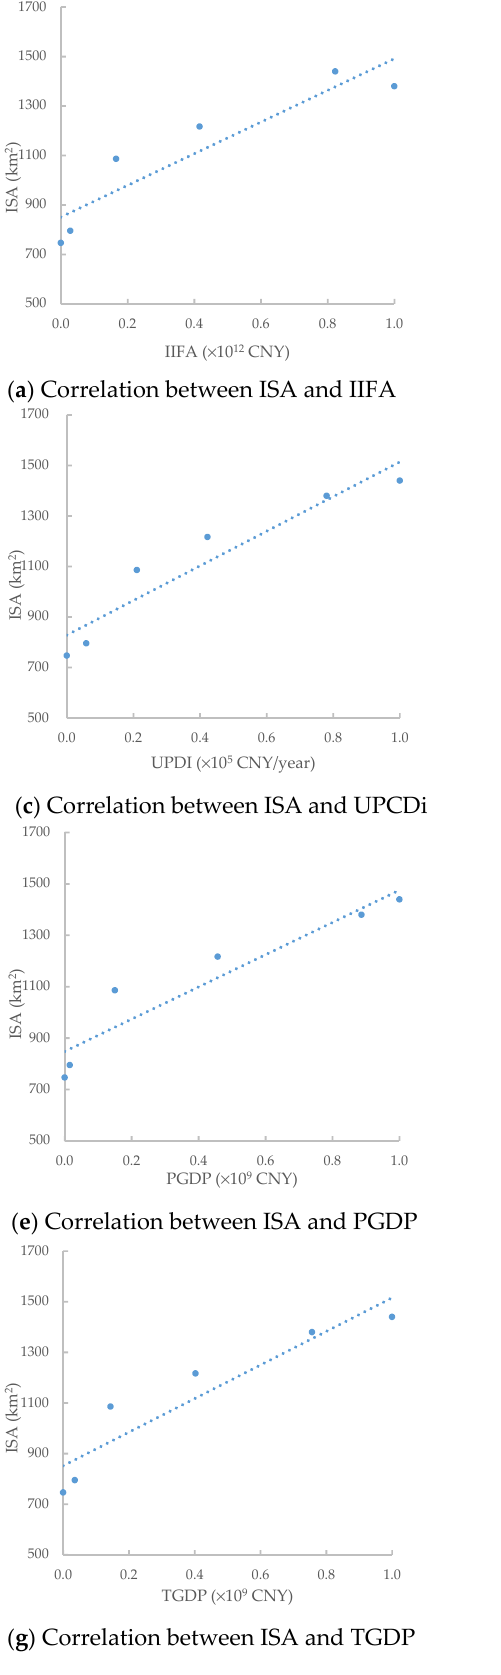
Figure 11. Correlation between ISA and socioeconomic